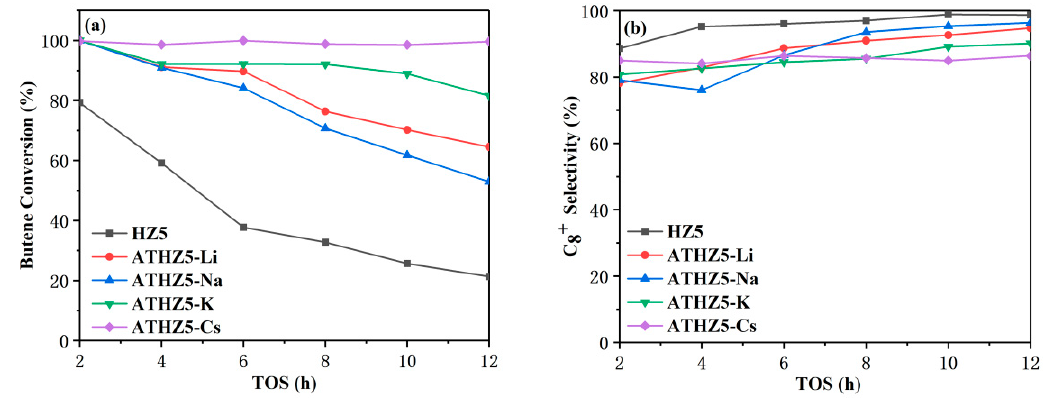
Figure 6. ( a ) Butene conversion and ( b ) C 8+ selectivity of catalytic oligomerization of HZ5 catalyst and modified catalysts. Reaction condition: temperature 573 K, pressure 1.5 MPa.